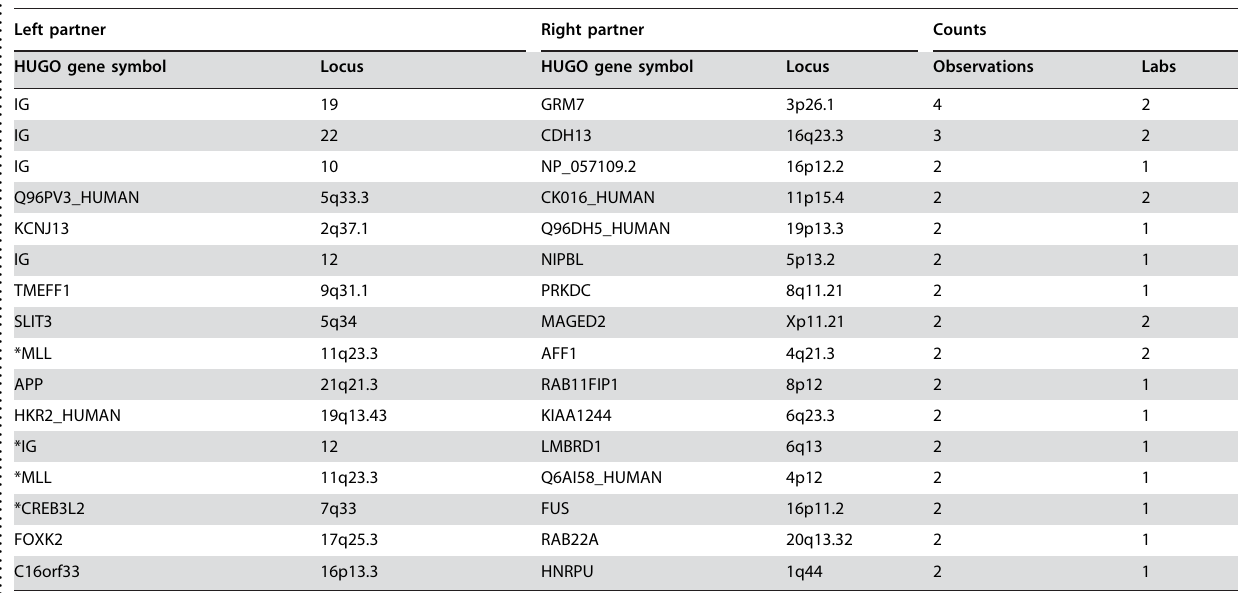
Table 4. Most common interactions for mRNA data. .. ... .... ... ... .... ... ... .... ... ... .... ... ... .... ... ... .... ... ... .... ... ... .... ... ... .... ... ... .... ... ... .... ... ... .... ... ... .... ... ... .... ... ...